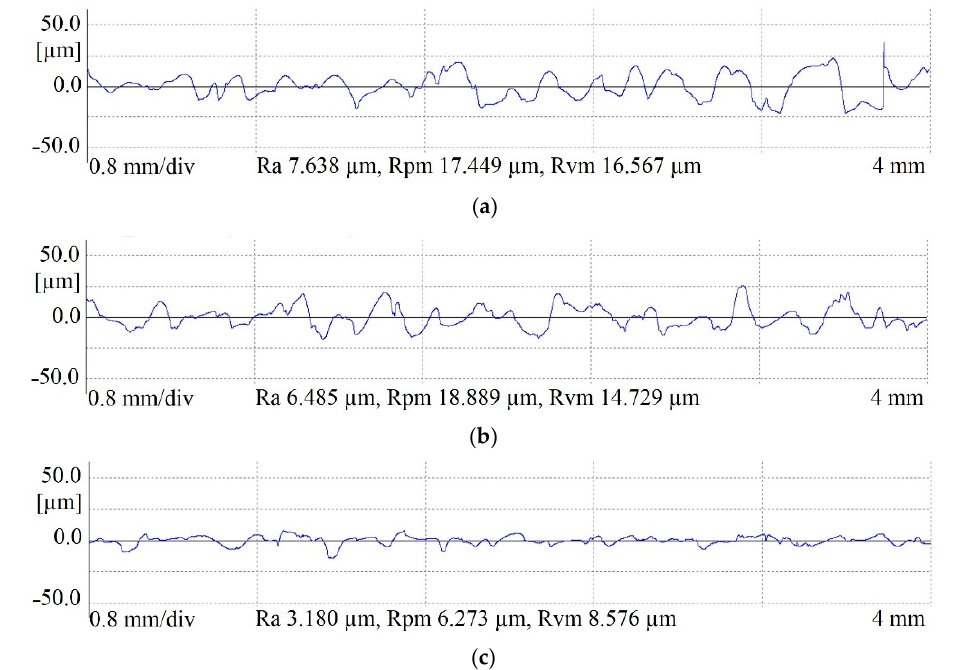
Figure 11. Profiles of the machined surface on the side wall of the hole drilled with the step cylindrical electrode (SCE). ( a ) SCE Ø 12 mm; ( b ) SCE Ø 9 mm; ( c ) SCE Ø 6 mm.